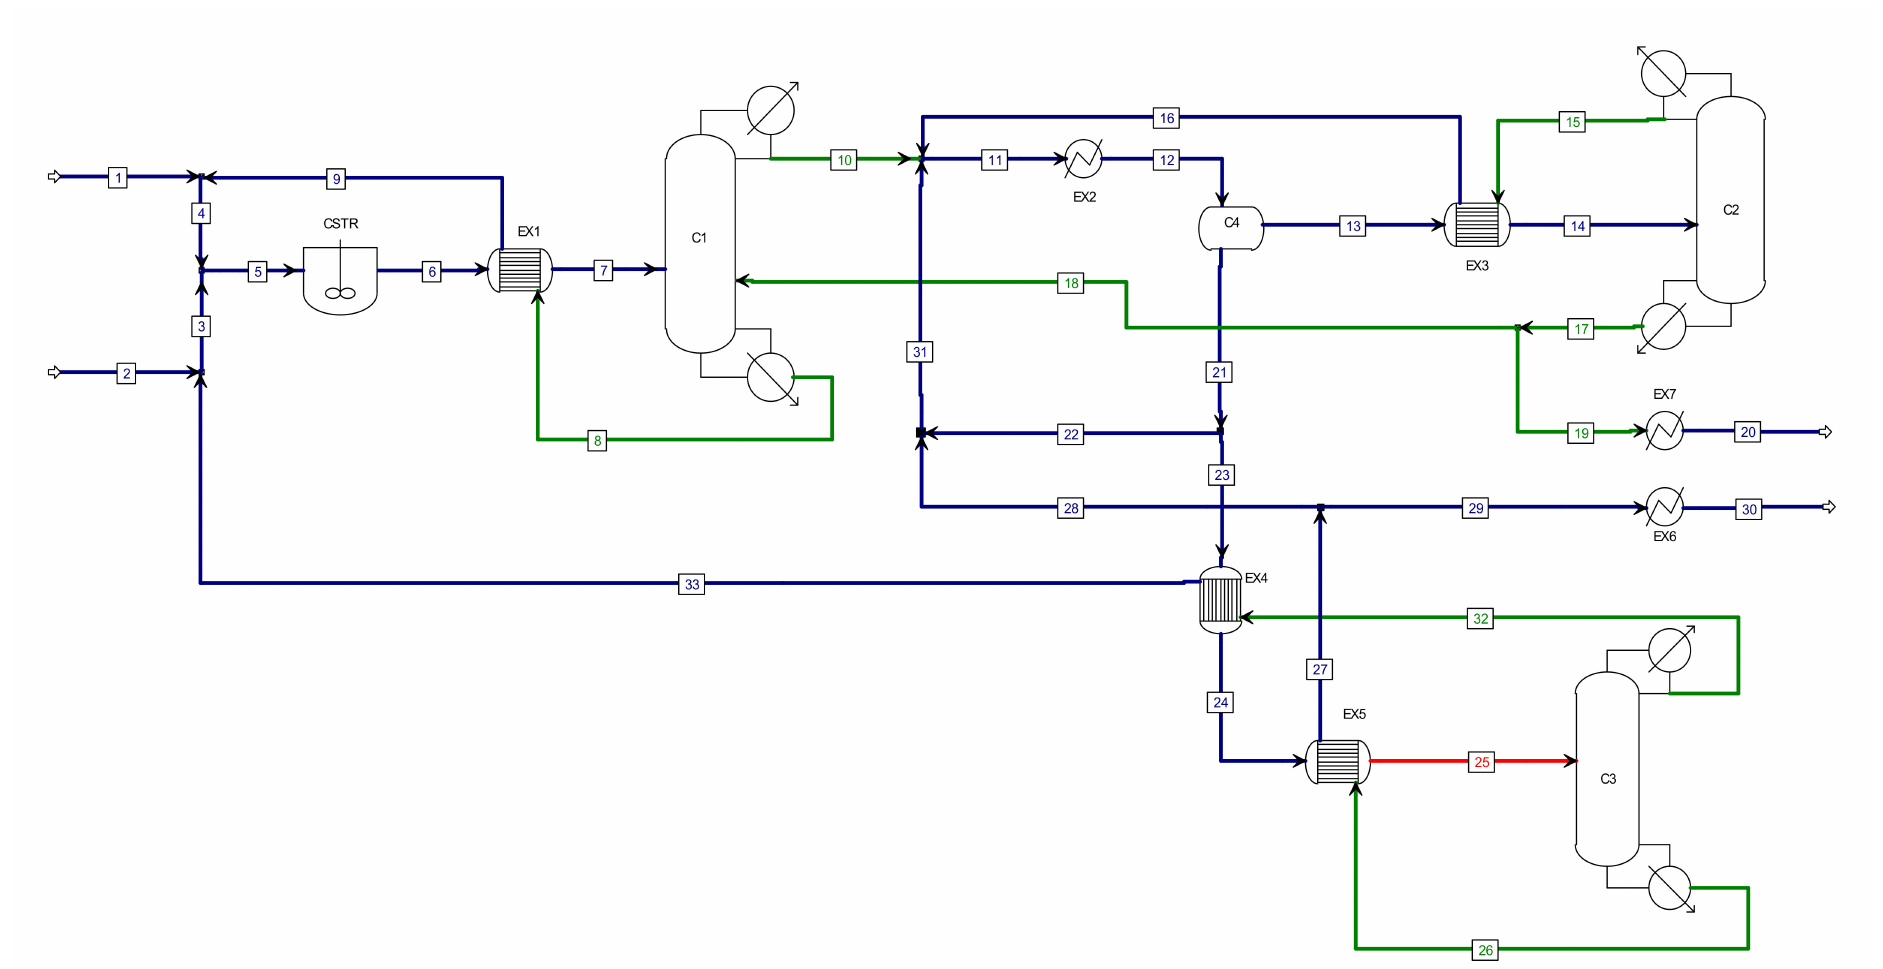
Figure 2. Ethyl acetate production via conventional process set-up adapted from our previous work [5]. Stream condition: blue—subcooled liquid; green—liquid at boiling temperature; red—vapor-liquid mixture. C1—azeotropic distillation column; C2, C3—distillation columns; C4—decanter; CSTR—continuous stirred tank reactor; EX1-7—heat